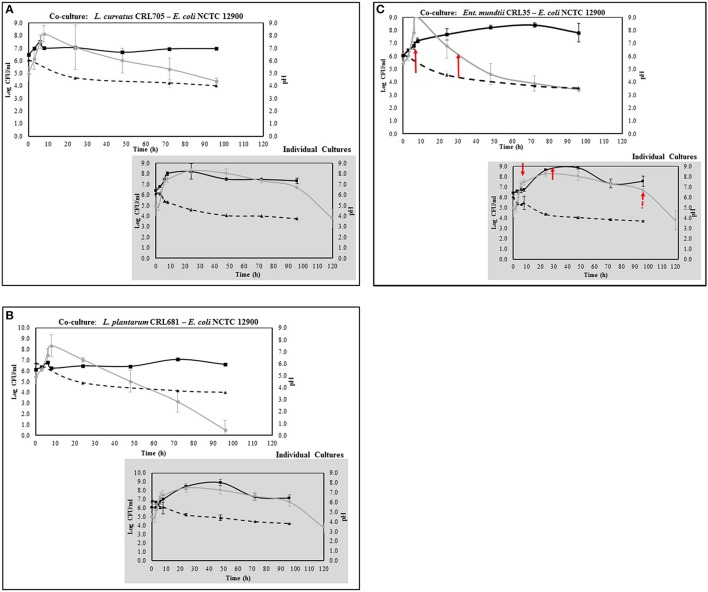
Kinetics of LAB (black line) and E. coli (gray line) growth (Log CFU/ml) in co- and individual culture in the sarcoplasmic model system at 30°C. The pH is represented with dashed line. (A) Co-culture and individual culture of L. curvatus CRL705, (B) Co-culture and individual culture of L. plantarum CRL681, (C) Co-culture and individual culture of Ent. mundtii CRL35. The red arrows indicate the time of sampling for proteomic assays.